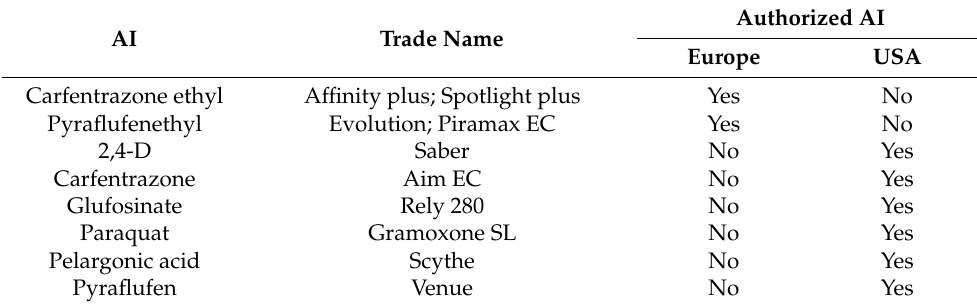
Table 1. Suckering herbicides authorized in Europe and USA (AI = active ingredient).